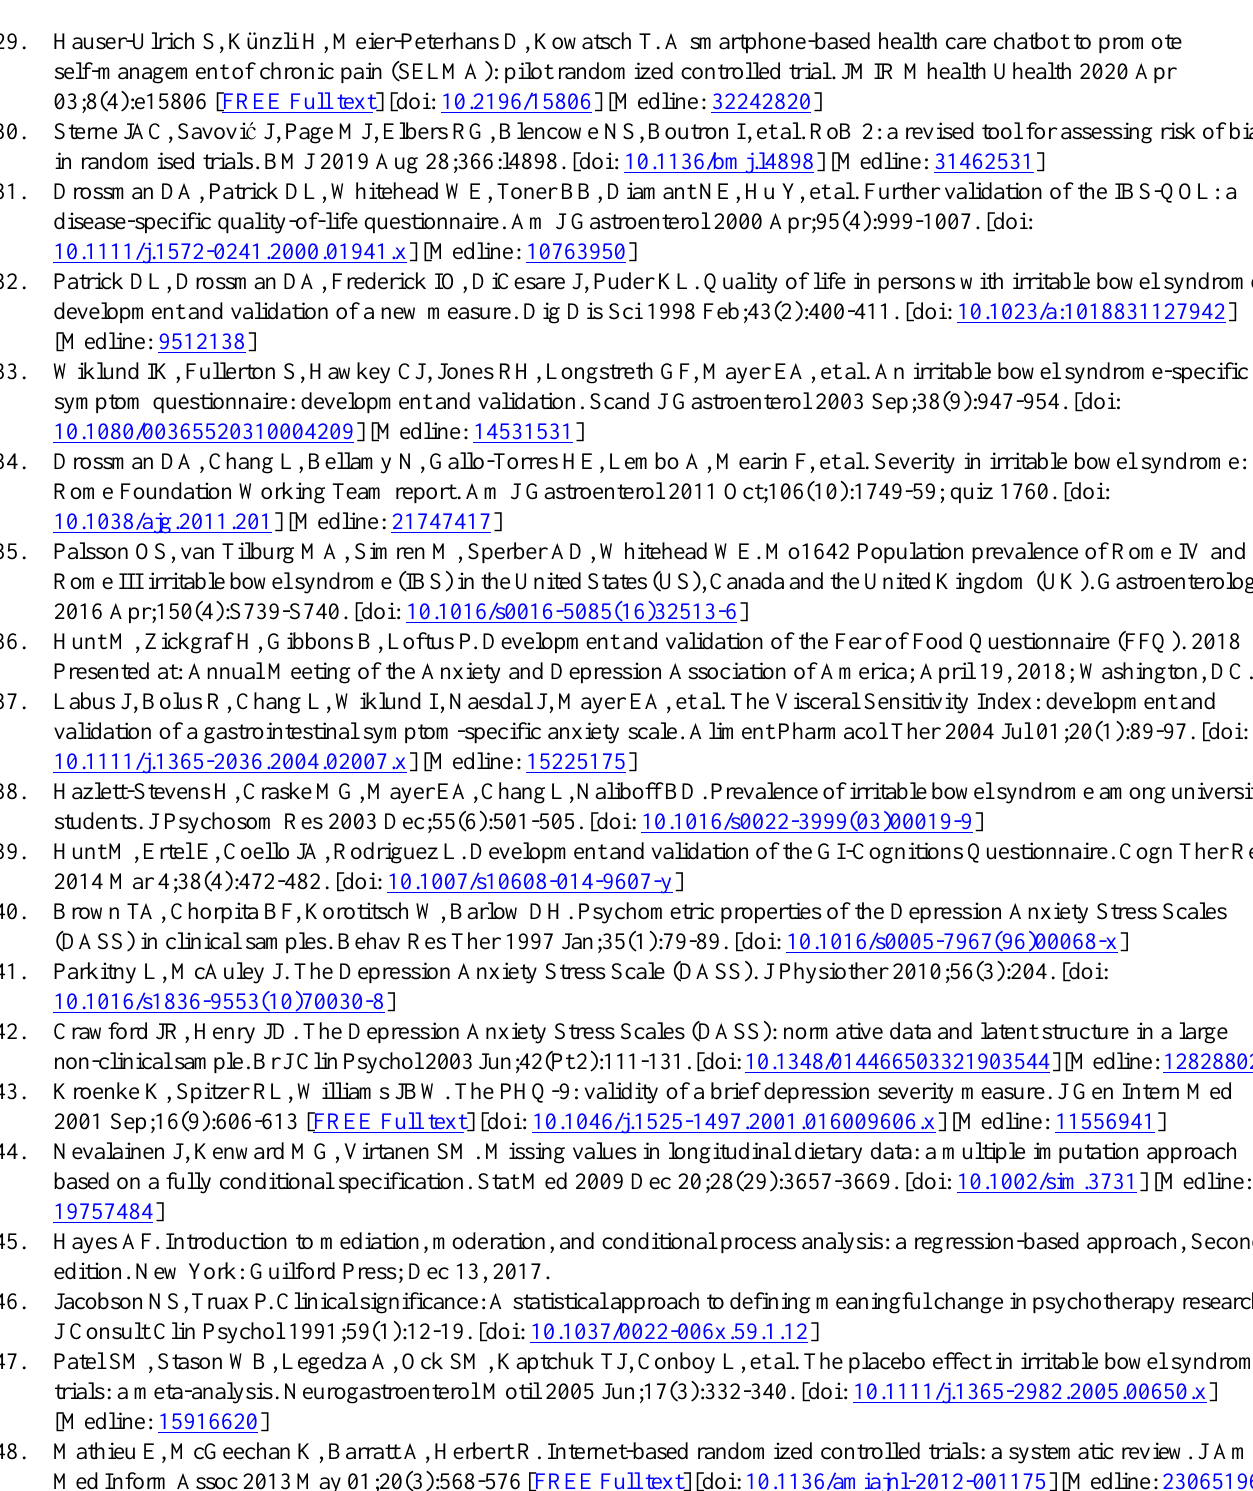
Abbreviations CBT: cognitive behavioral therapy DASS: Depression Anxiety Stress Scale FFQ: Fear of Food Questionnaire GI: gastrointestinal GI-COG: Gastrointestinal Cognitions Questionnaire GSRS: Gastrointestinal Symptom Rating Scale HRQL: health-related quality of life